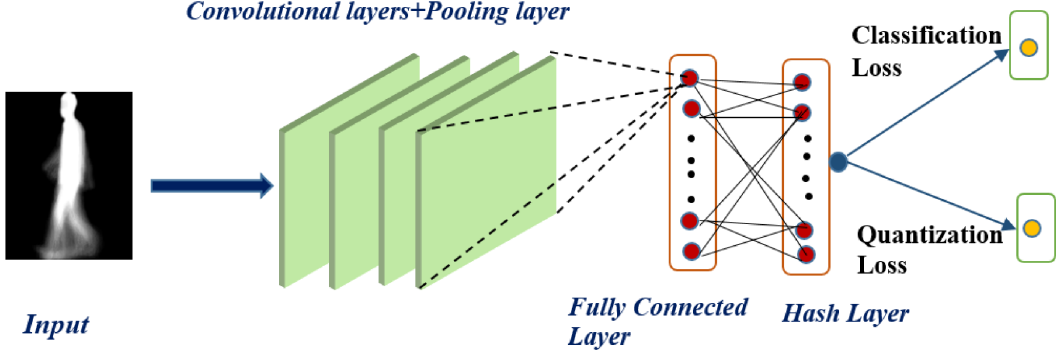
Figure 2. The architecture for the proposed deep gait retrieval hashing (DGRH)